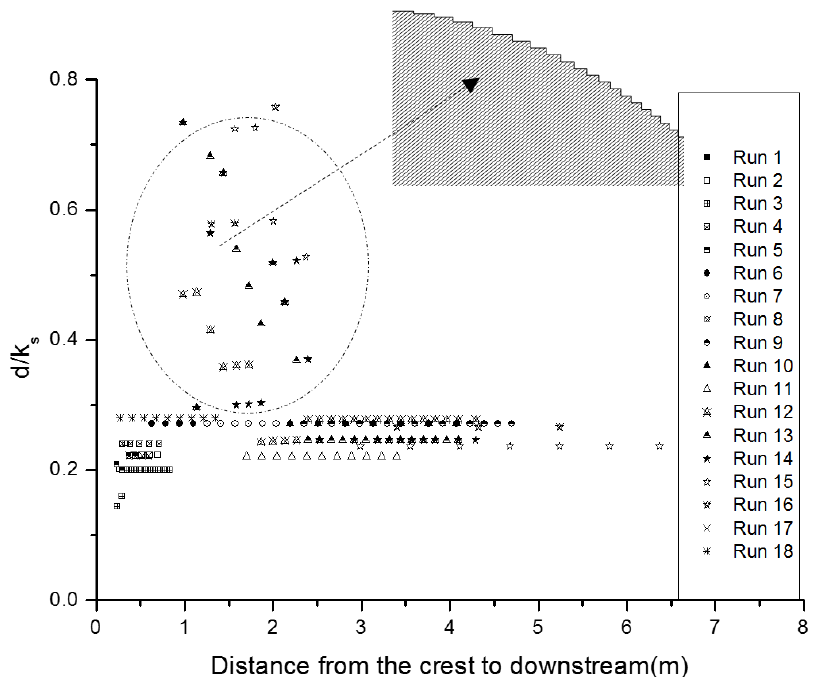
Figure 9. The relationship of d and k s